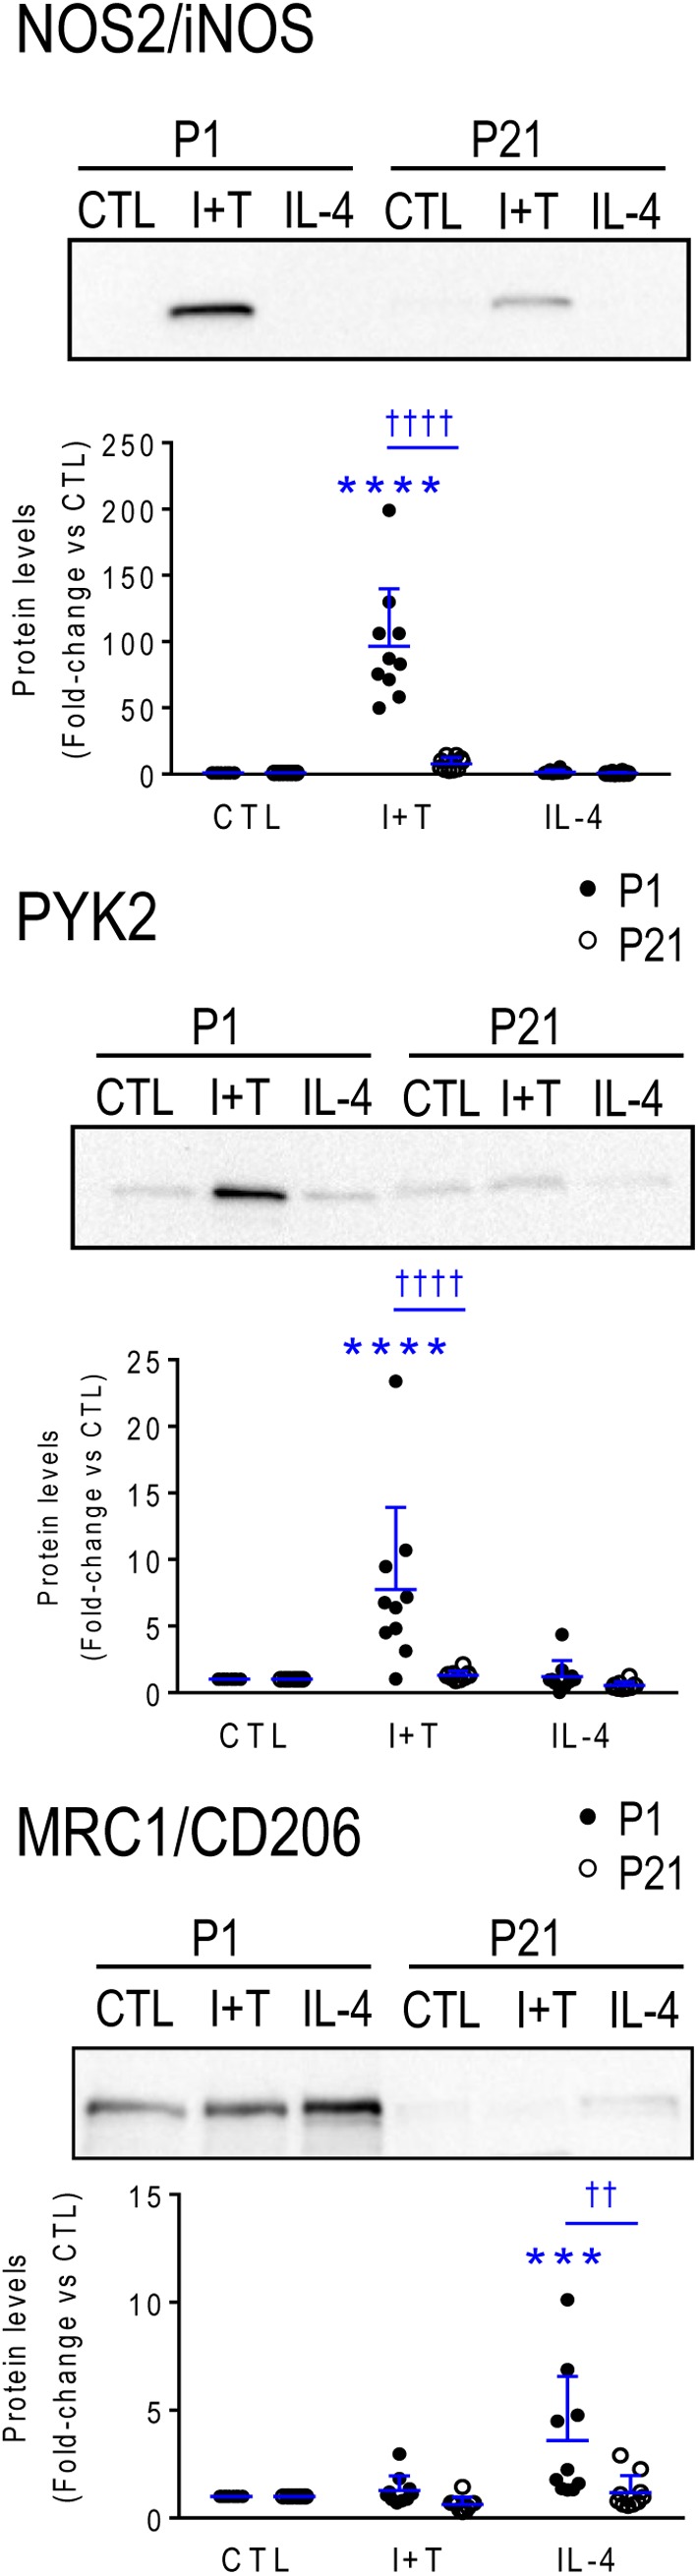
Neonatal (P1) versus prepubertal (P21) microglia: Exemplary pro- and anti-inflammatory proteins. Rat microglia were harvested 24 h after treatment with IFNγ + TNFα (I+T) or IL-4. (Upper) Representative Western blots for the pro-inflammatory markers, iNOS and PYK2, and the anti-inflammatory marker, MRC1/CD206. (Lower) Individual values of fold-changes with respect to unstimulated (control) microglia and the mean ± SD are shown. Significant differences are shown between control and treated cells (∗) and between P1 and P21 microglia (†). Two symbols of either type indicate p < 0.01; 3 indicates p < 0.001 and 4 indicates p < 0.0001.